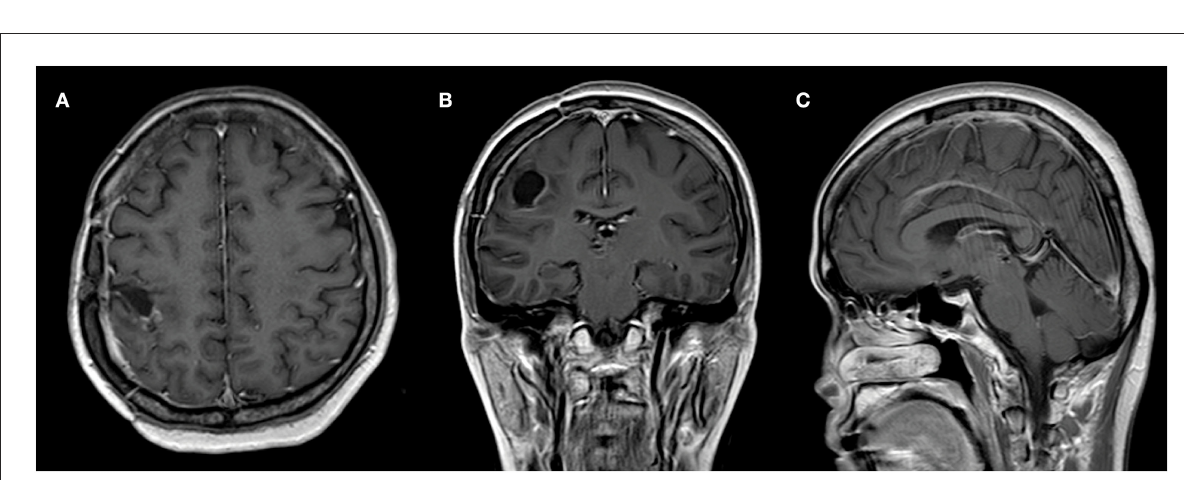
FIGURE4 Axial (A) , coronal (B) , and sagittal (C) MR scan with contrast showing no tumor growth at the 2-year